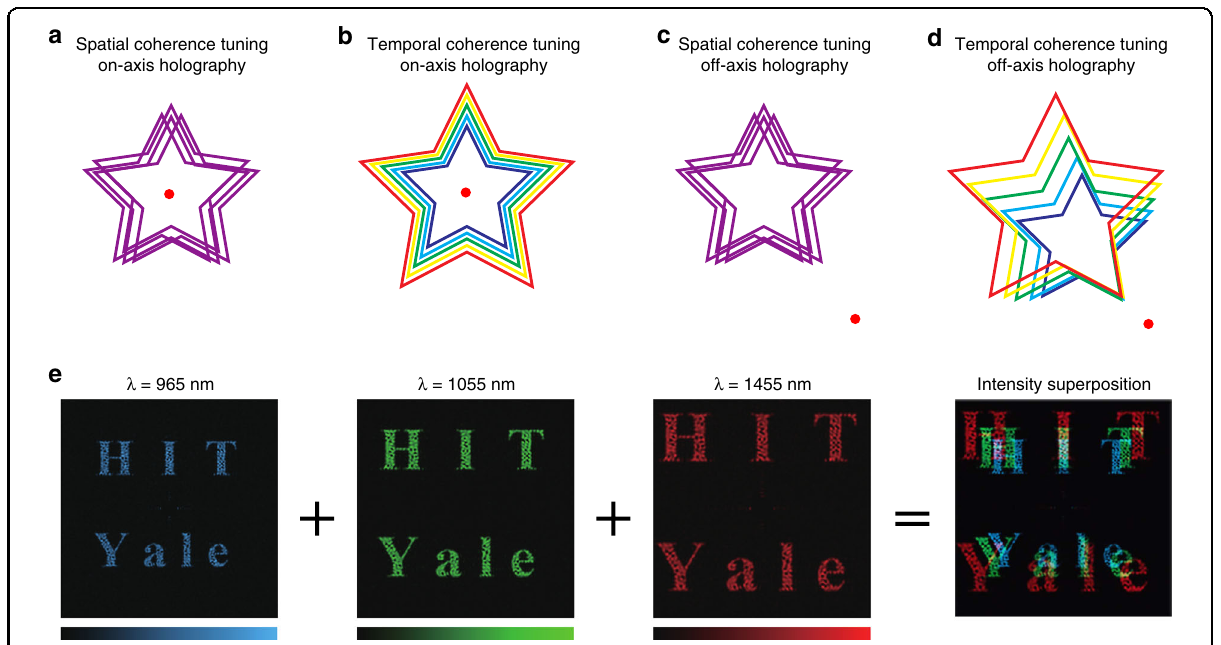
Fig. 6 Comparison of spatial and temporal coherence tuning on holographic image quality. a – d Schematic of holographic images created by illuminating light with low spatial coherence and high temporal coherence ( a , c ), or with low temporal coherence but high spatial coherence ( b , d ) for on-axis holography ( a , b ) and off-axis holography ( c , d ). The optical axis is marked by a red dot. Lowering the temporal coherence results in stronger and non-uniform edge blurring than lowering the spatial coherence. e Numerically calculated meta-holographic images created by plane wave illumination at wavelengths λ = 965 nm, 1055 nm, 1455 nm. Pseudo-colors are used to label the wavelengths. The image size increases with wavelength, and an intensity sum of these images produces a radially extended